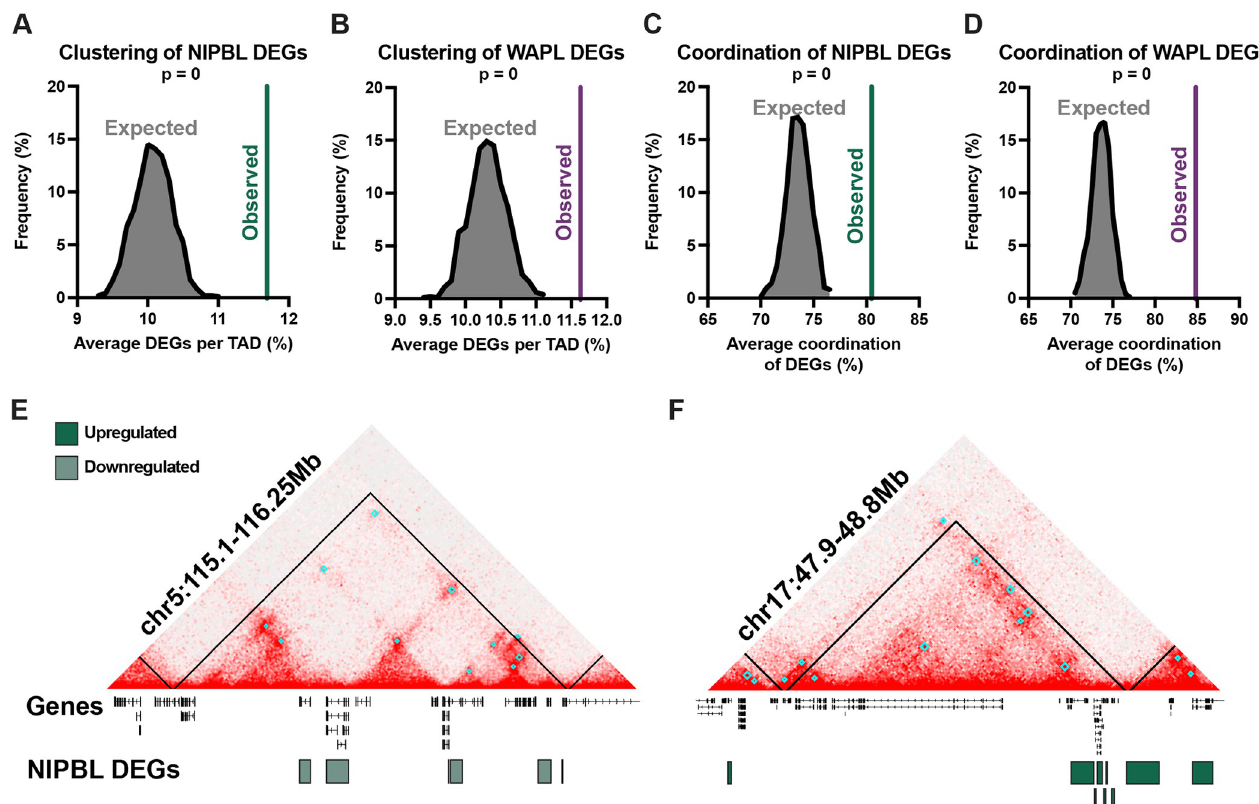
at least one expressed gene. Exact test, p = 0. (B) The observed average percentage of WAPL DEGs per TAD compared to a null distribution (expected). Permutations generated by shuffling the DEG and nonDEG designations across genes 1,000 times. Analysis limited to TADs with at least one expressed gene. Exact test, p = 0. (C) The average coordination of NIPBL DEGs compared to a null distribution generated by shuffling the fold change amongst the DEGs 1,000 times. Analysis limited to TADs with at least two expressed genes. Exact test, p = 0. (D) The average coordination of WAPL DEGs compared to a null distribution generated by shuffling the fold change amongst the DEGs 1,000 times. Analysis limited to TADs with at least two expressed genes. Exact test, p = 0. (E) Representative TAD with 100% DEG coordination on chr5 which contains six downregulated NIPBL DEGs. Black lines represent TADs, cyan boxes represent loops. (F) Representative TAD with 100% DEG coordination on chr17 which contains nine upregulated NIPBL DEGs. Black lines represent TADs, cyan boxes represent